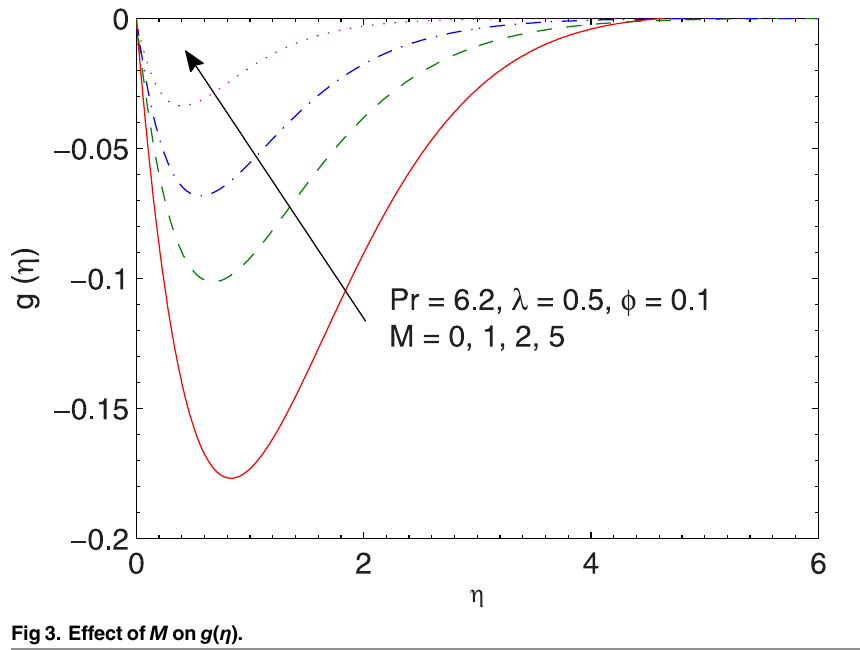
Fig 3. Effect of M on g ( η